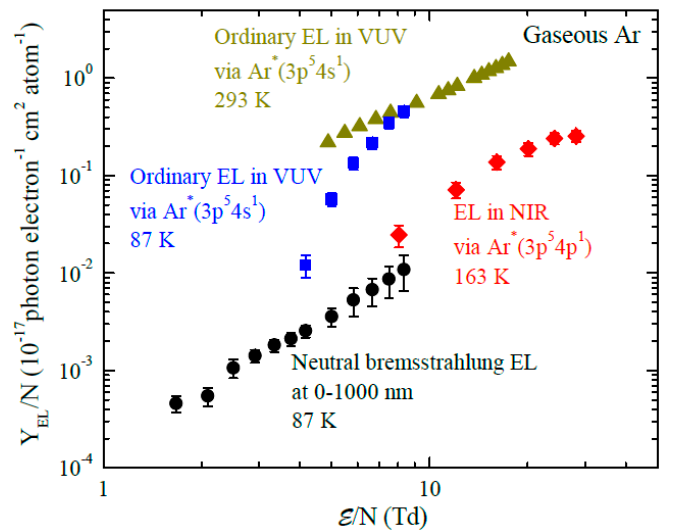
Figure 5. Summary of experimental data on reduced electroluminescence (EL) yield in gaseous Ar for all known (EL) mechanisms: for NBrS EL below 1000 nm, measured in [9,13] at 87 K; for ordinary EL in the VUV, due to excimer emission going via Ar * (3p 5 4s 1 ) excited states, measured in [9,13] at 87 K and in [14] at 293 K; for EL in the NIR due to atomic transitions going via Ar * (3p 5 4p 1 ) excited states measured in [15] at 163 K.